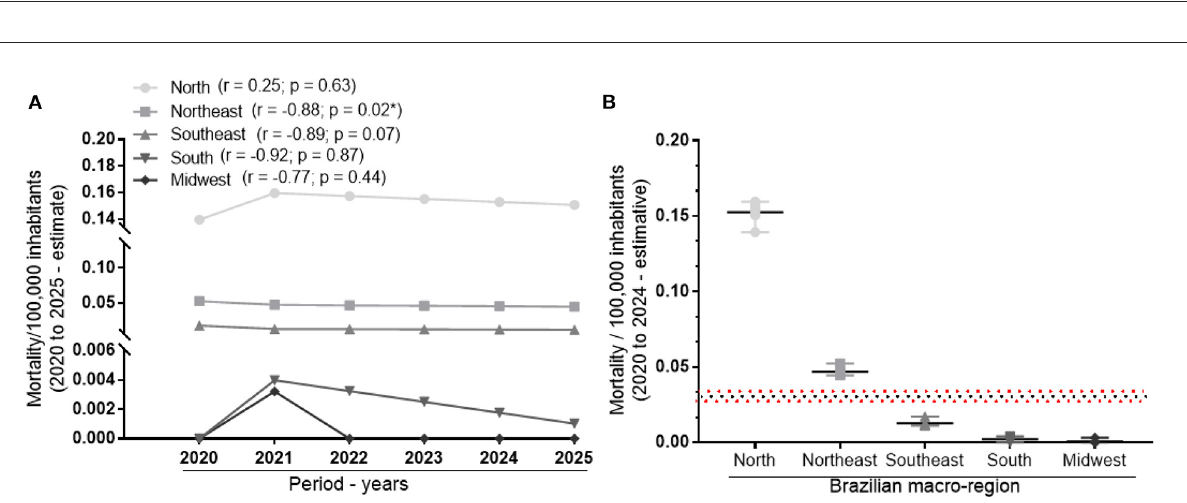
FIGURE2 Prospective evaluation for correlation and comparison of mean distributions of the prevalence of mortality from severe child malnutrition between 2020 and 2025 for the Brazilian macro-regions. (A) Temporal correlation between mortality per 100,000 inhabitants and the period of six years. (B) Comparison between the average frequencies of mortality per 100,000 inhabitants for the different macro-regions. Spearman’s test was used to evaluate correlations and the Kruskal-Wallis test with Dunn’s multiple comparison post-test was used to compare distributions. Statistically significant differences were considered when p < 0.05. The * indicate statistically significant